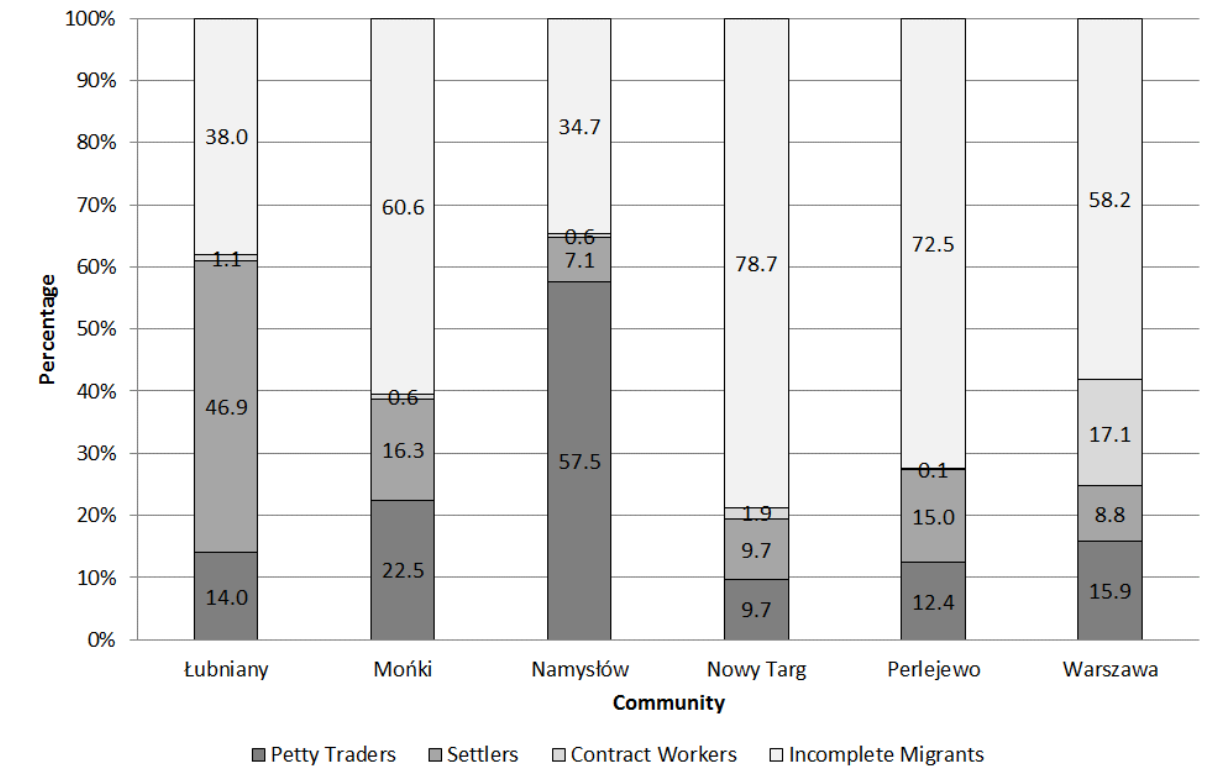
Figure 1. Typology of migrants identified in ethnosurveys completed in Poland, 1994–1996